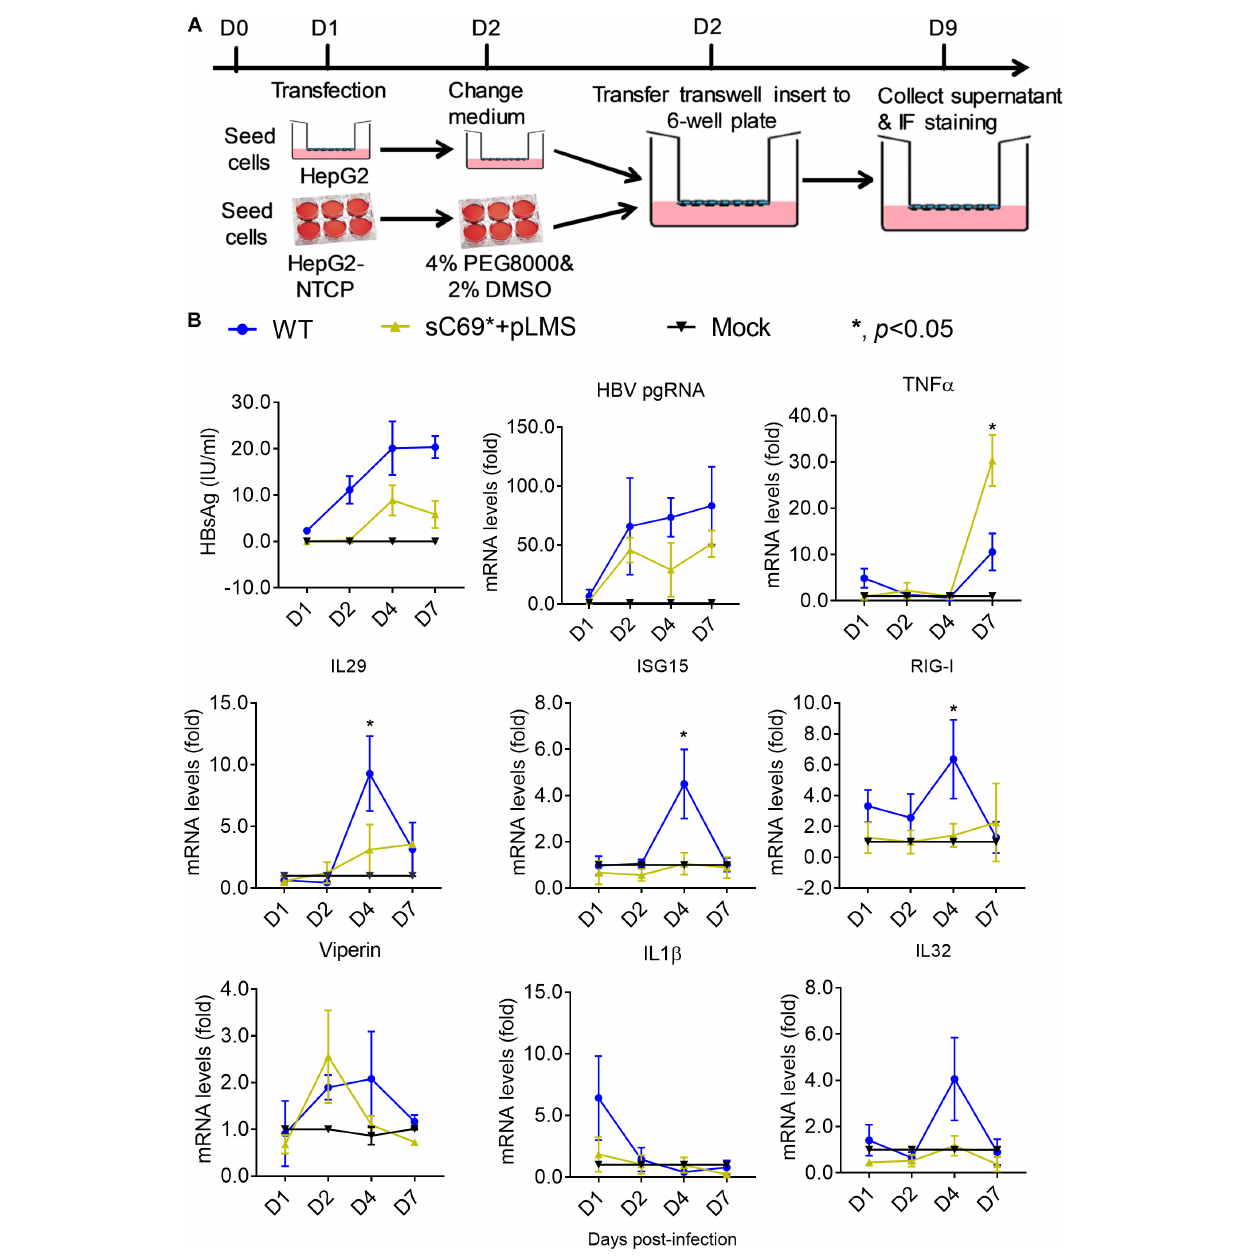
FIGURE 5 | The sC69 ∗ mutant inhibits host innate immune response compared to HBV WT in trans -well system. (A) The schematic illustration of HBV WT and sC69 ∗ + pLMS infection. The HepG2 cells were seed in the insert of the transwell and the HLCs were prepared. We transfected HBV WT and sC69 ∗ + pLMS plasmid into HepG2 cells and washed the cells with PBS the next day. The day after, we transferred the insert to the top of HLCs and cultured as indicated. (B) CLIA detection for HBsAg and RT-qPCR for detecting HBV pgRNA and mRNAs of TNF α , IL29, ISG15, RIG-I, viperin, IL1 β , and IL32 after 500 geq/cell HBV infection for different days. Data from three biological replicates are shown as means ± s.d. Statistical analysis was performed by a Student’s t -test ∗ p <